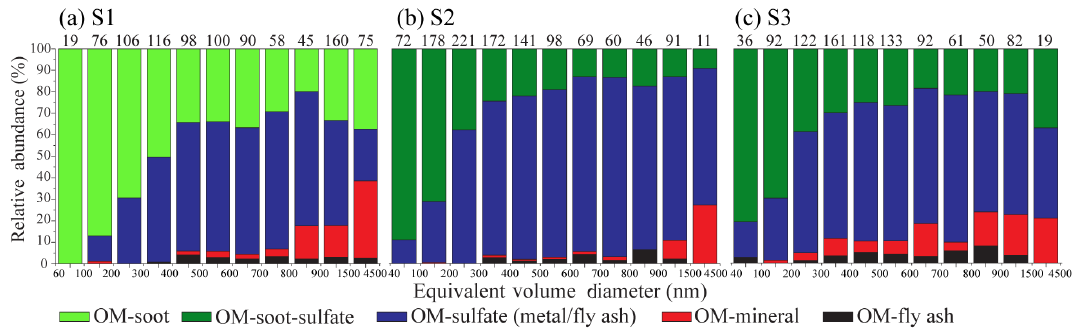
Figure 6. Number fractions of OM internally mixed particles at (a) the S1 site (urban Jinan), (b) S2 site (top of Mt. Tai), and (c) S3 site (polluted background). The number of analyzed particles in different size ranges is shown above each